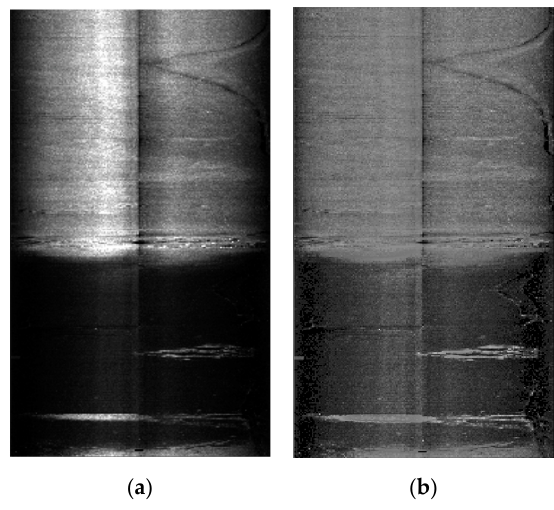
Figure B1. Side-scan sonar image enhancement from Zhao, J et al. [9]: (a) original image with changes Figure A1. Side-scan sonar image enhancement from Zhao, J et al. [9]: ( a ) original image with changes in sediments and (b) enhanced image (bilateral filtering, A = 140, a = 17). in sediments and ( b ) enhanced image (bilateral filtering, A = 140, a = 17).